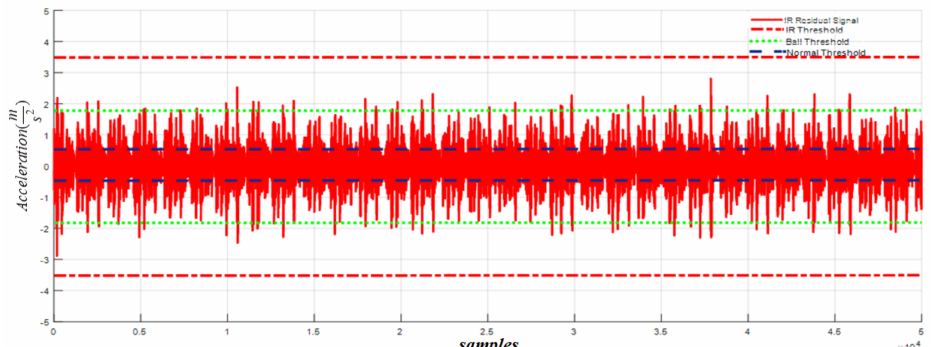
Figure 11. Residual of acceleration for inner fault signal: normal threshold ( ± 0.5), ball fault threshold ( ± 1.8), and inner fault threshold ( ± 3.5) at a crack width of